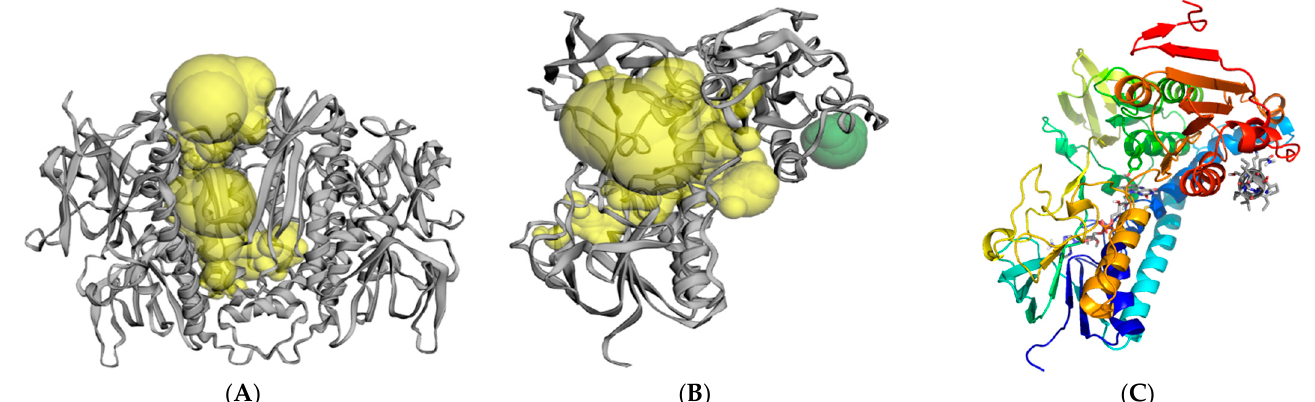
Figure 1. ( A ) An illustration of the Li TryR dimer (PDB entry 6I7N [27]) showing the large channel (yellow) connecting the NADPH entry site to the interfacial cavity [28], as calculated by the CASTp web server [32]; ( B ) an illustration of a Li TryR monomer showing a similar channel (yellow, 2016 Å 2 , 2550 Å 3 ) plus a second one (green, 129 Å 2 , 125 Å 3 ) that makes up the putative target site for the dimer-disrupting peptides and SMPCs; ( C ) theoretical model of the complex between pro- totype peptide TRL38 (C atoms in grey) and a Li TryR monomer (rainbow-colored illustration, with N - and C-termini in blue and red, respectively).